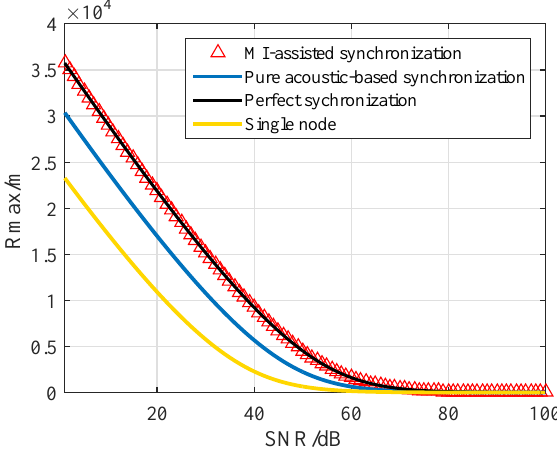
Figure 5. The inter-cluster maximum transmission